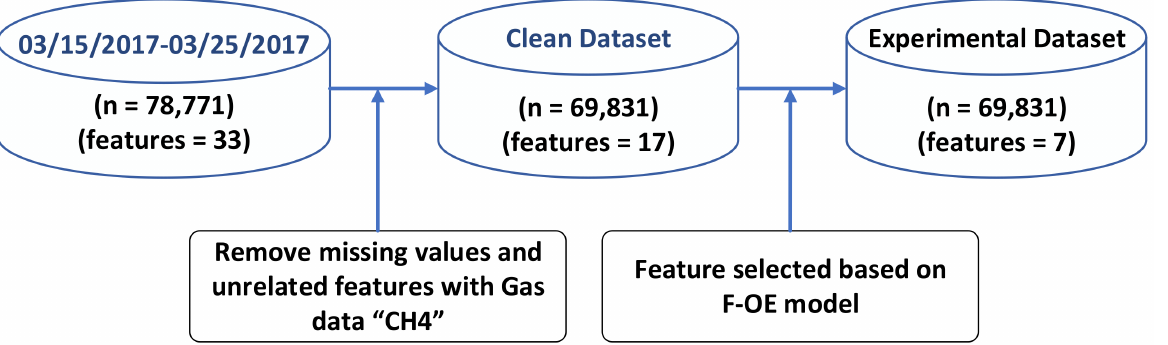
Figure 5. The experimental dataset preparation procedure of the NG